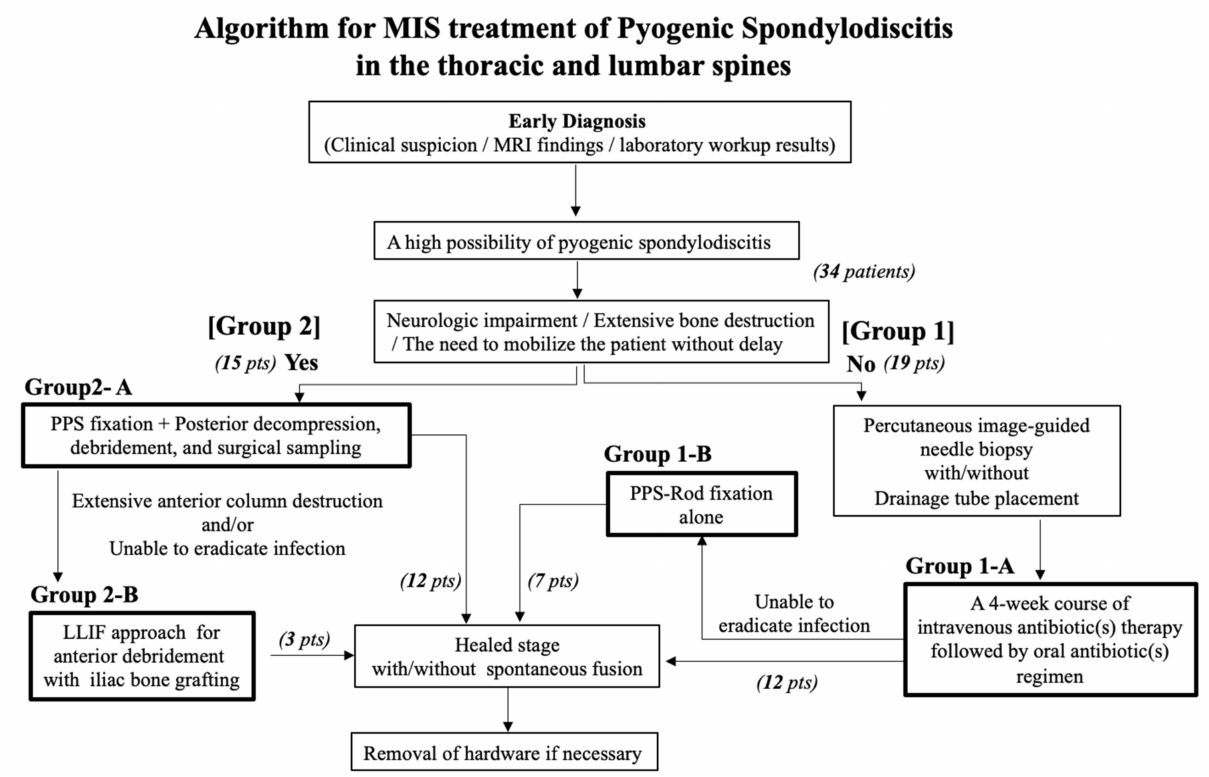
Figure 1. A new treatment algorithm that incorporates minimally invasive surgery for pyogenic spondylodiscitis in the thoracic and lumbar spines. The algorithm first divided the patients into those who had escaped complicated disease conditions, such as neurologic impairment, extensive bone destruction, and the need to be mobilized without delay (Group 1; 19 patients), and those who had complicated pyogenic spondylodiscitis (Group 2; 15 patients). Group 1 patients had image-guided needle biopsy followed by nonoperative treatment (Group 1-A; 12 patients) or a subsequent addition of non-fused PPS–rod fixation (Group 1-B; 7 patients). Group 2 patients underwent an immediate single-stage MIS with non-fused PPS–rod fixation followed by posterior exposure for decompression and debridement through a small midline incision (Group 2-A; 12 patients) or an additional LLIF procedure after an interval of 3 weeks (Group 2-B; 3